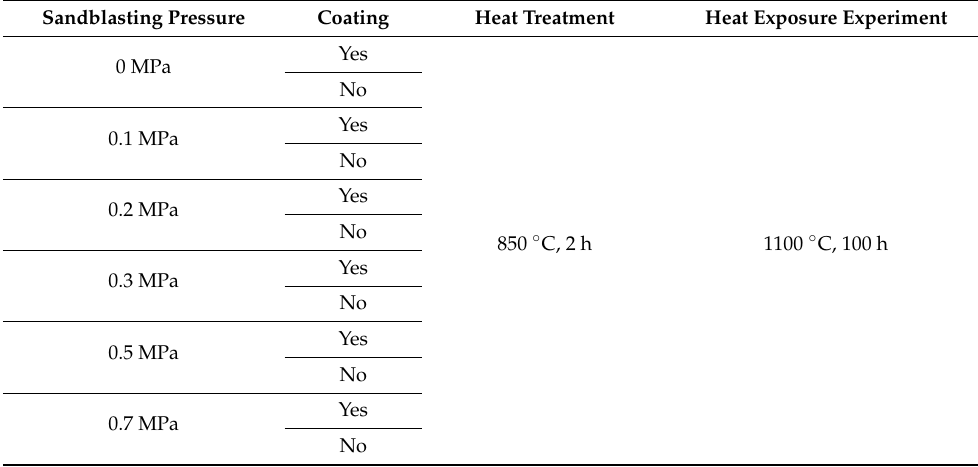
Table 2. Sandblasting and coatings conditions of the single crystal superalloy